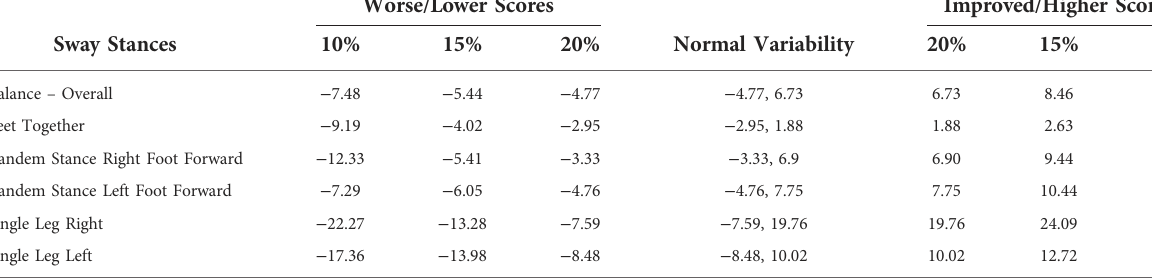
TABLE 4 Interpreting change based on the natural distribution of week 2 – week 1 difference scores.